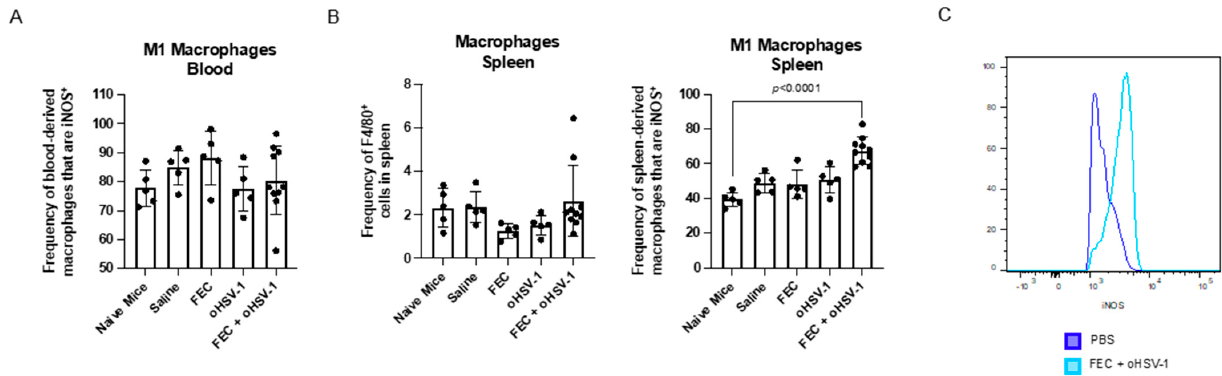
Figure 5. FEC + oHSV-1 therapy increases M1-like macrophages in the spleen. C57/Bl6 mice bearing E0771 subcutaneous tumors were treated with either PBS ( n = 5), FEC ( n = 5), oHSV-1 ( n = 5), or FEC + oHSV-1 ( n = 10). Mice were sacrificed, and blood and spleens were harvested 10 days after the start of treatment for analysis via flow cytometry. ( A ) Bar plots showing the frequencies of M1 macrophages (CD11b + F4/80 + iNOS + cells) in the peripheral blood. Dots are representative of individual mice. Error bars are representative of the standard deviation. ( B ) Bar plots showing the frequencies of macrophages (CD11b + F4/80 + cells) and M1 macrophages (CD11b + F4/80 + iNOS + cells) in the spleen. Dots are representative of individual mice. Error bars are representative of the standard deviation. ANOVA test was used for statistical analyses. ( C ) Representative flow histogram showing the expression of iNOS in macrophages from the spleens of mice treated with either PBS or FEC + oHSV-1.